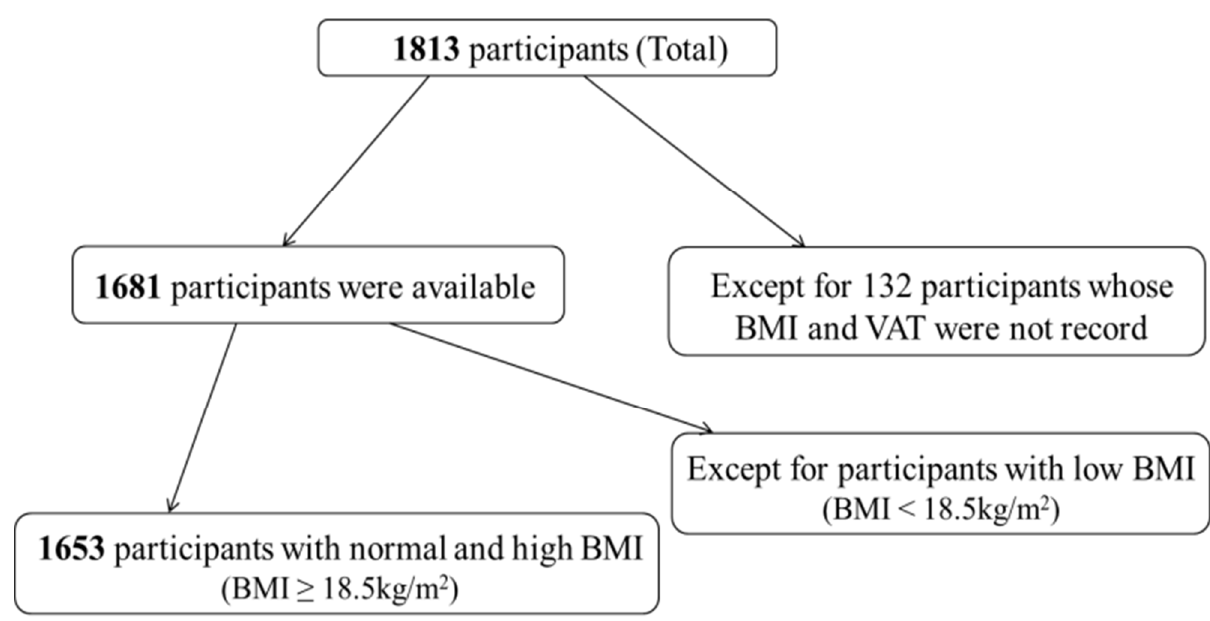
Figure 1. Schematic diagram of participant grouping. A total of 1813 Chinese adults received health assessments and were recruited for the study. From this number, 132 participants were excluded due to invalid BMI or visceral fat data, and 28 were excluded because their BMI was <18.5 kg/m 2 . BMI, body mass index; VAT, visceral adipose tissue.